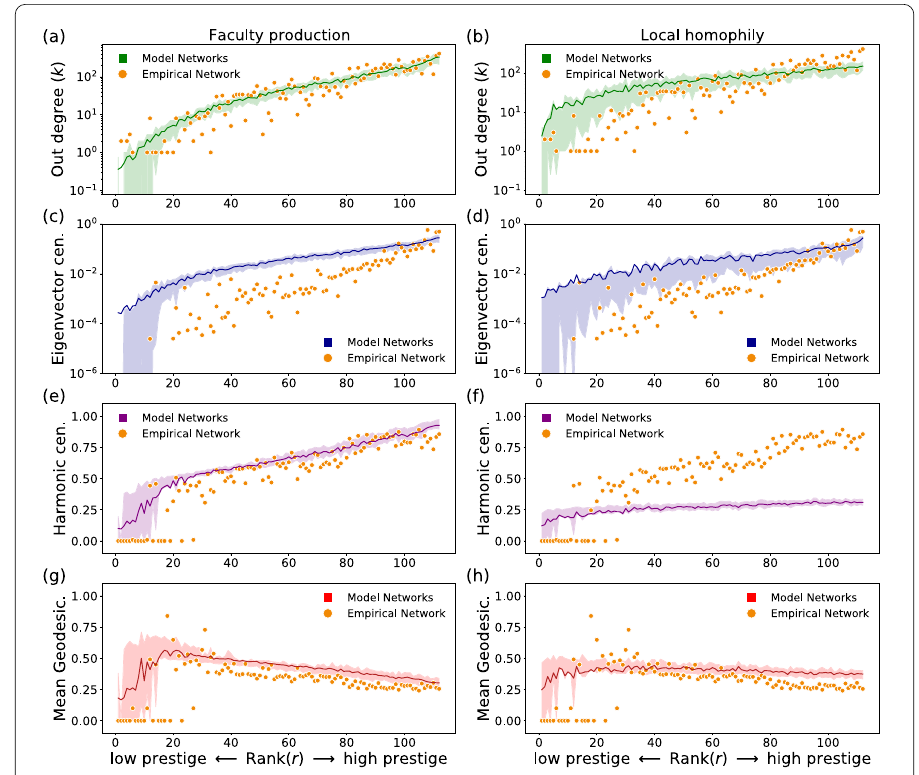
Figure 3 Structural patterns of hiring model networks for two mechanisms of Faculty production and Local homophily and the empirical Business hiring network as a function of prestige. ( a ), ( b ) Out-degree k i , ( c ), ( d ) eigenvector centrality, ( e ), ( f ) harmonic centrality, and ( g ), ( h ) mean geodesic distance normalized by network diameter. Panels on the left ( a ), ( c ), ( e ), ( g ) show results for the Faculty production model, and panels on the right ( b ), ( d ), ( f ), ( h ) show results for the Local homophily model (skewed initialization). Solid lines indicate the mean over 50 simulations, and shaded region around the mean indicates the 25% to 75% quantile